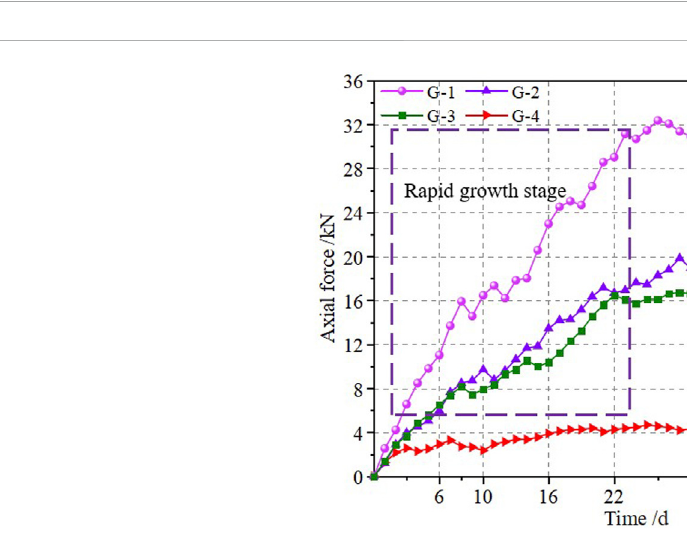
FIGURE 6 Stress of surrounding rock.